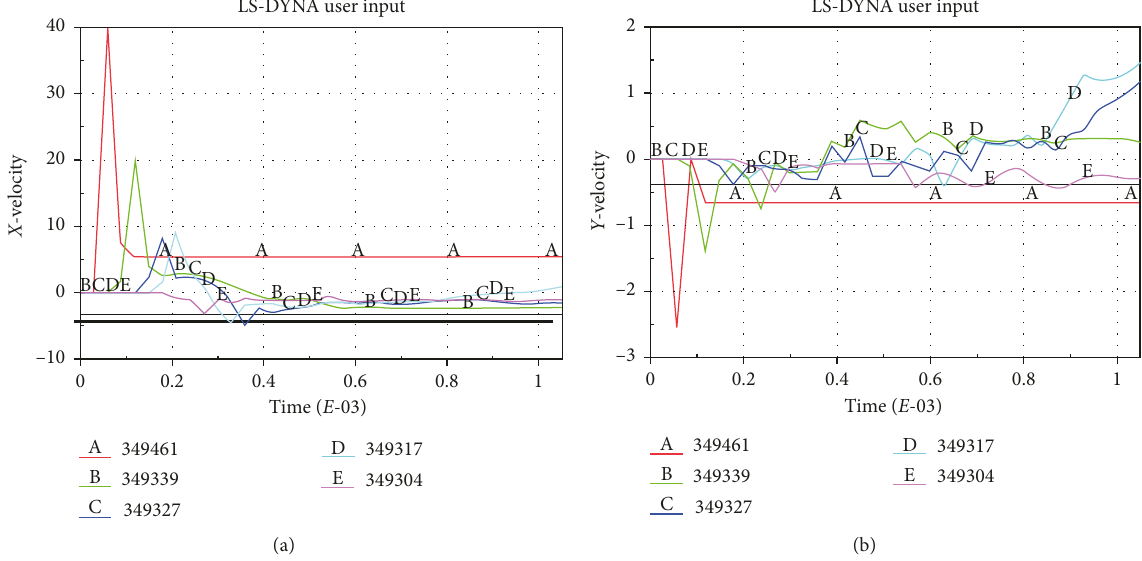
Figure 13: Attenuation curve of blasting velocity on the rock elements under different directions. (a)Horizontal direction (m/s). (b)Vertical direction (m/s).